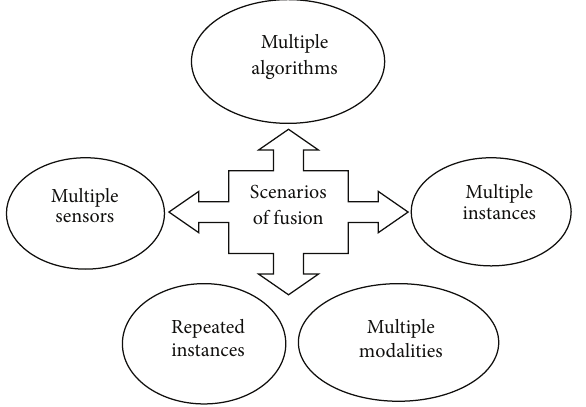
Figure 1: Fusion scenarios of multimodal systems.